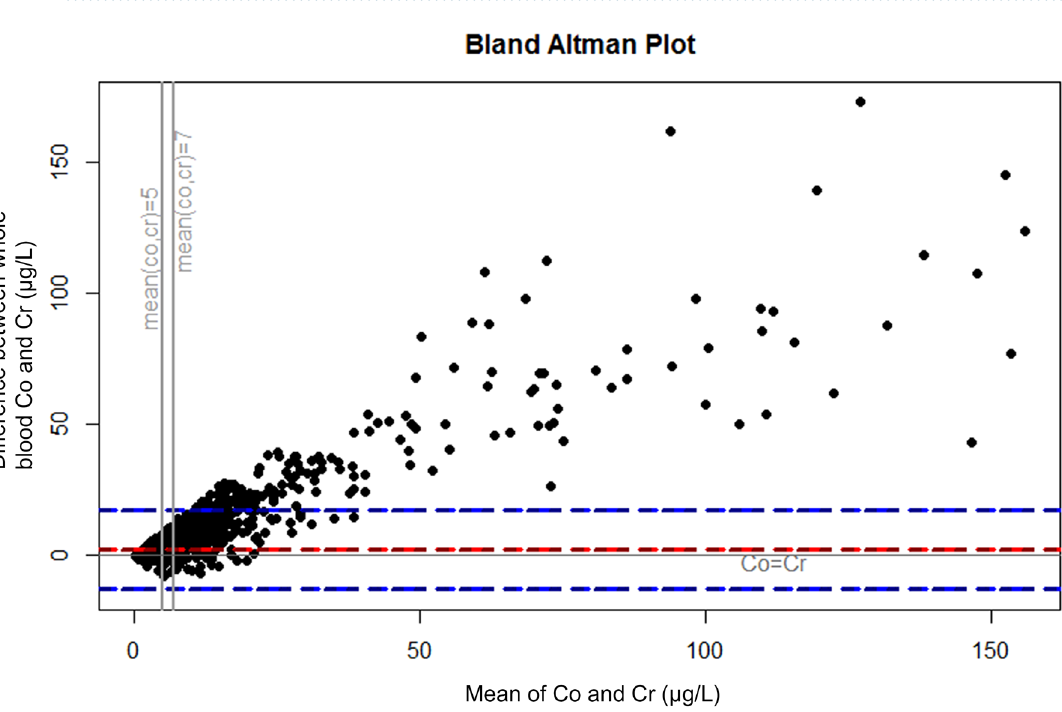
Figure 2. Bland–Altman plot representing the difference between whole blood Co and Cr in relation to the mean of whole blood Co and Cr (µg/L). In the measurements below zero the whole blood Cr is higher than Co. The red line represents the mean difference and blue lines 95% confidence intervals. Measurements before/ without revision surgery from all patients with MoM hip replacement. Figure drawn with R (Version 3.5.1) 21